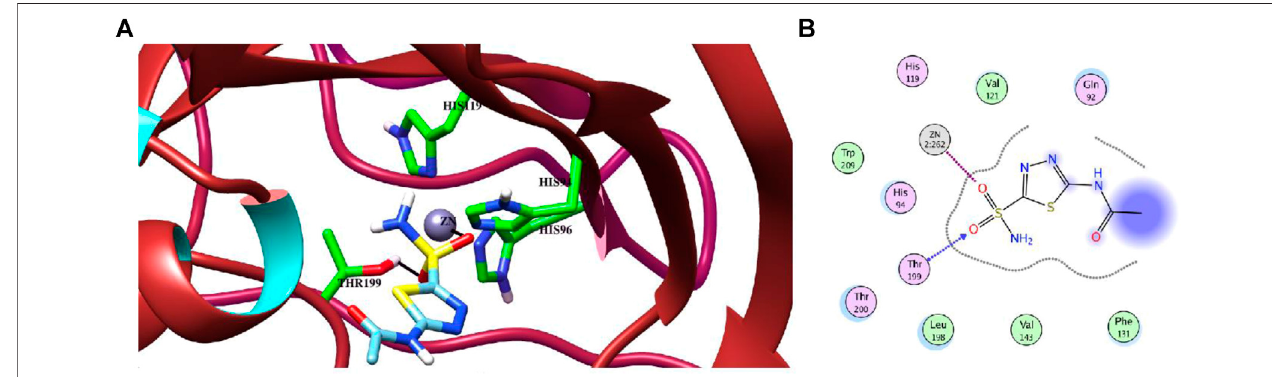
FIGURE4|(A) Thebinding mode ofthe standardinhibitor “ acetazolamide (AZM) ” intheactive siteofCA-II inthe3D form. H-bond and metal-ligandinteractionare shown in black lines. (B) The protein-ligand interaction is shown in 2D form. The H-bond and metal-ligand interaction are displayed in blue and magenta dotted lines,